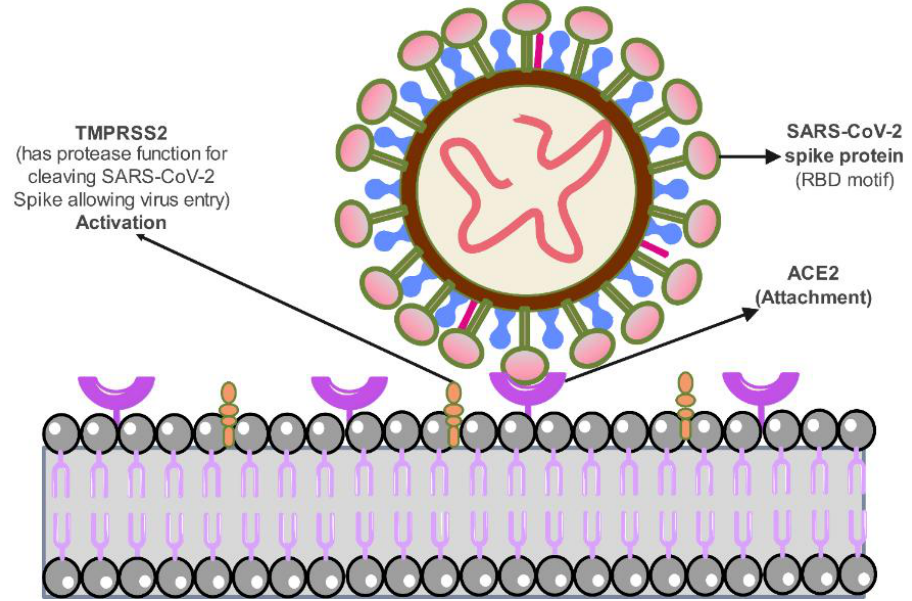
Figure 2. Schematic illustration displays the role of ACE2 and TMPRSS-2 receptors in SARS-CoV-2 attachment and infection.